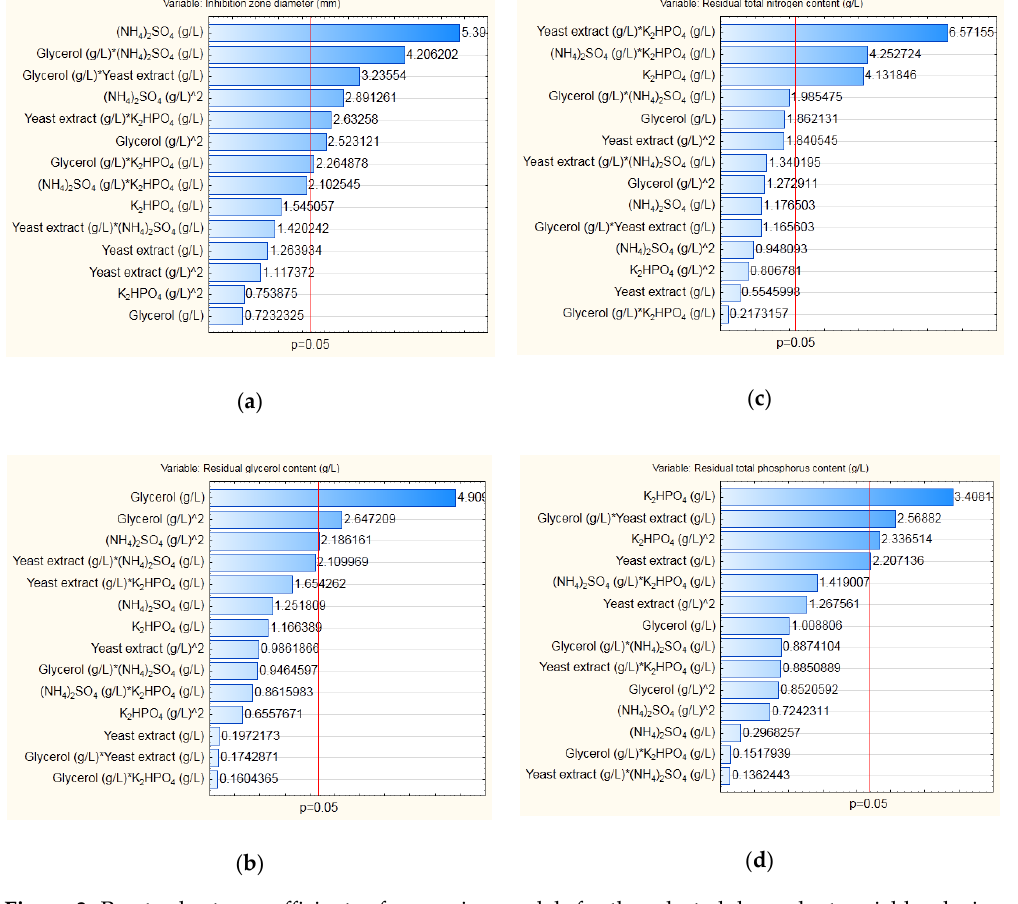
Table 2. ANOVA (analysis of variance) for the selected responses in the phase of modeling of medium composition for cultivation of B. velezensis IP22.